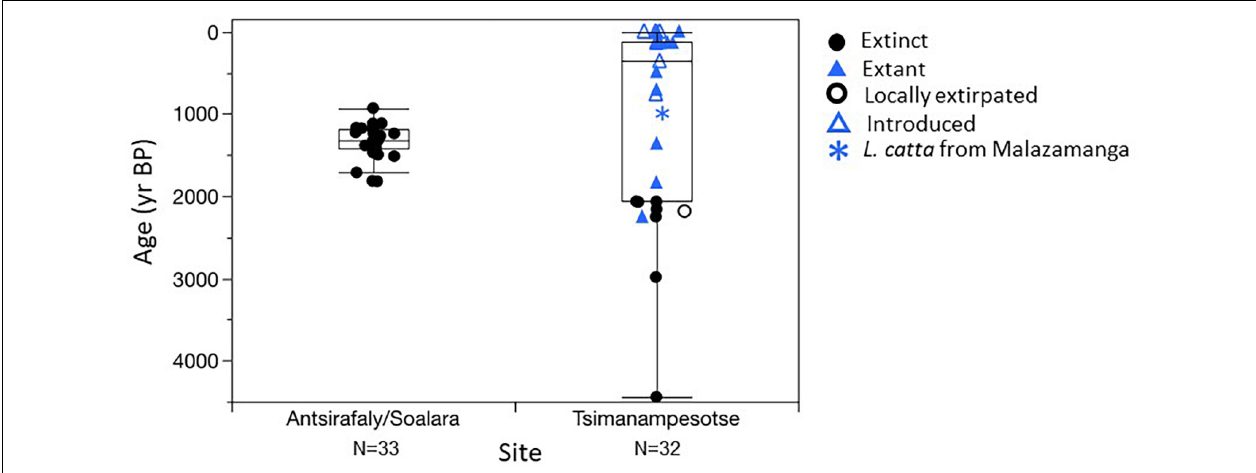
FIGURE 5 | Distribution of calibrated dates for extinct, extant, locally extirpated, and introduced taxa at Antsirafaly and Tsimanampesotse. The date for a humerus of the extant Lemur catta at Malazamanga is highlighted (blue asterisk) because of its possible temporal association with several bones of extinct species ( Megaladapis edwardsi , Hippopotamus lemerlei , and Cryptoprocta spelea ). See